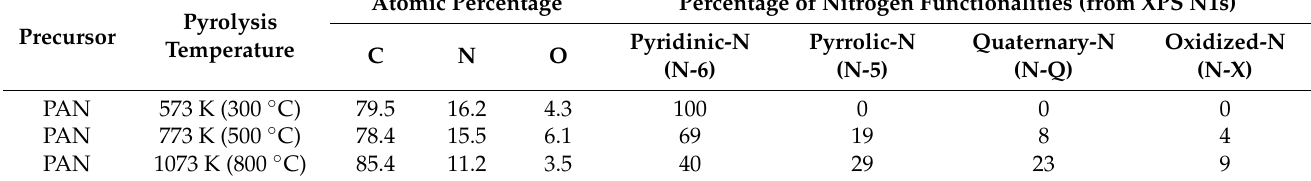
Table 3. XPS data from calcined PAN at different temperatures (heating rate of 1 ◦ C/min, dwell time of 1 h, and Ar atmosphere). Reprinted and adapted with permission from ref. [80]; Copyright 1995, Elsevier Science Ltd.